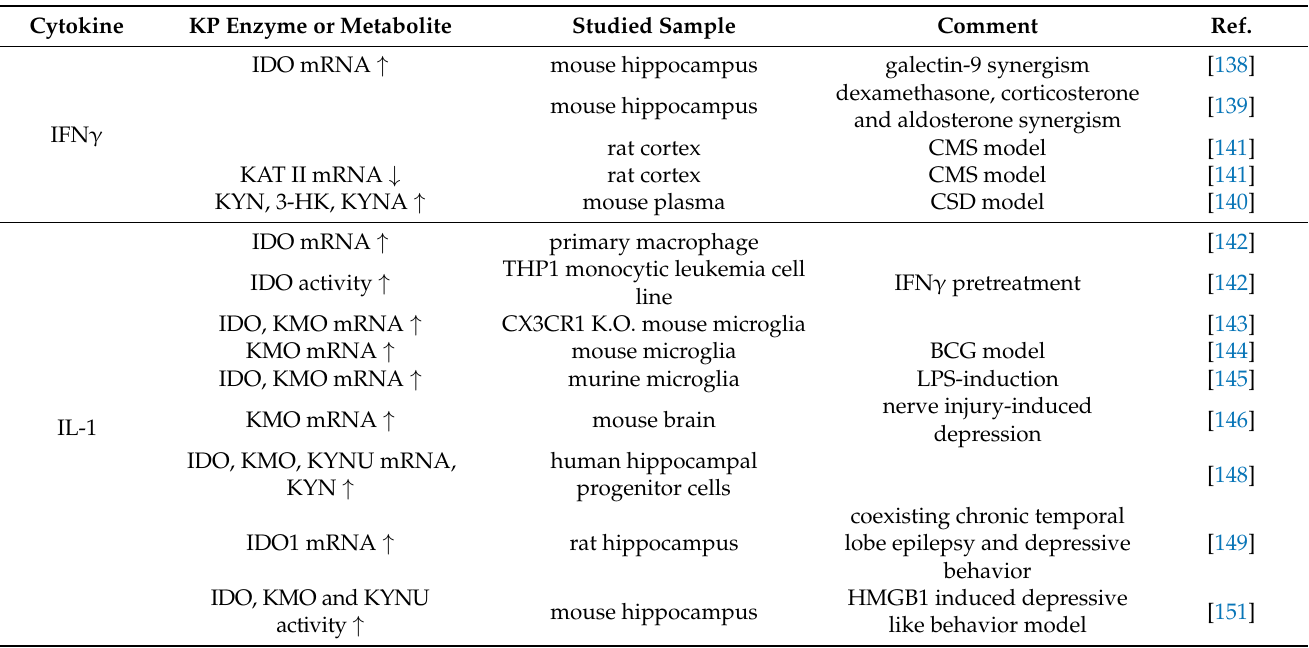
Table 2. Summarizing the data regarding upregulated pro-inflammatory cytokines associated with altered KP enzymes or